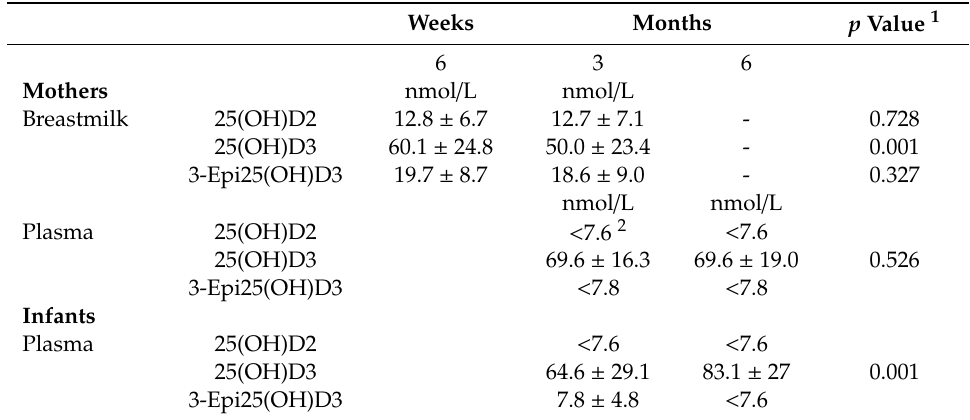
Table 5. Concentration levels of 25(OH)D2, 25(OH)D3, and 3-Epi25(OH)D3 at 6 weeks, 3, and 6 months among mother and infant. Paired samples